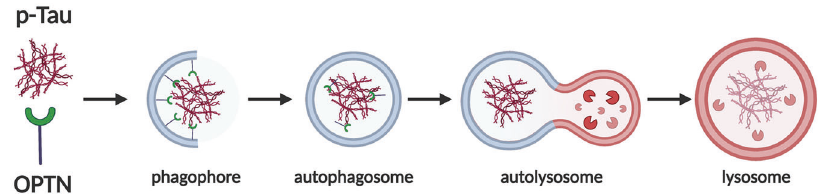
Fig. 8 Diagrammatic sketch of the mechanism of OPTN. OPTN as an autophagy receptor recognizes p-tau and facilitates its autophagic degradation. Created with